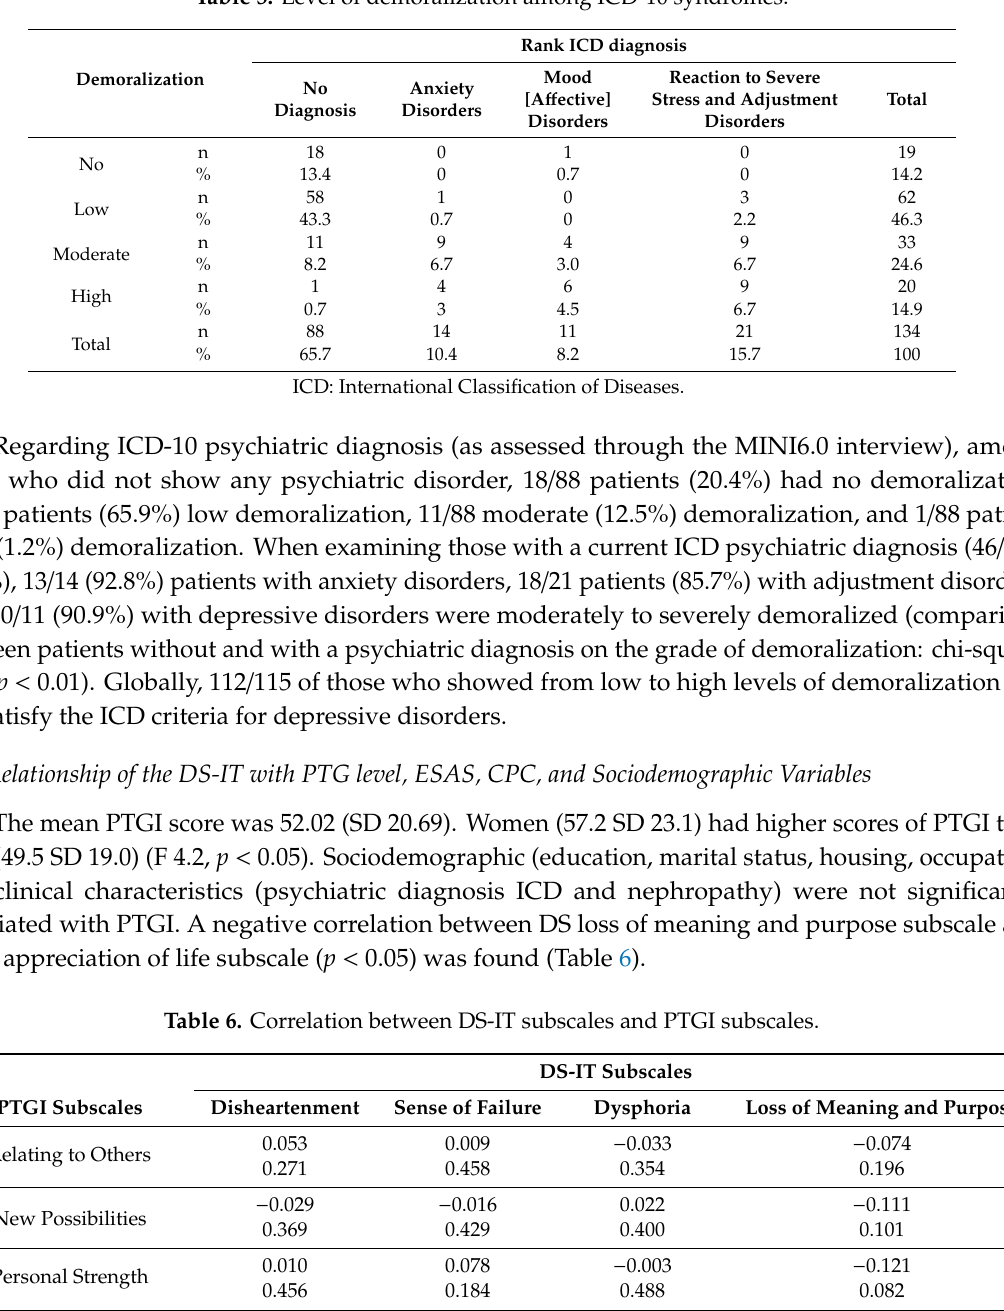
Table 5. Level of demoralization among ICD-10 syndromes.